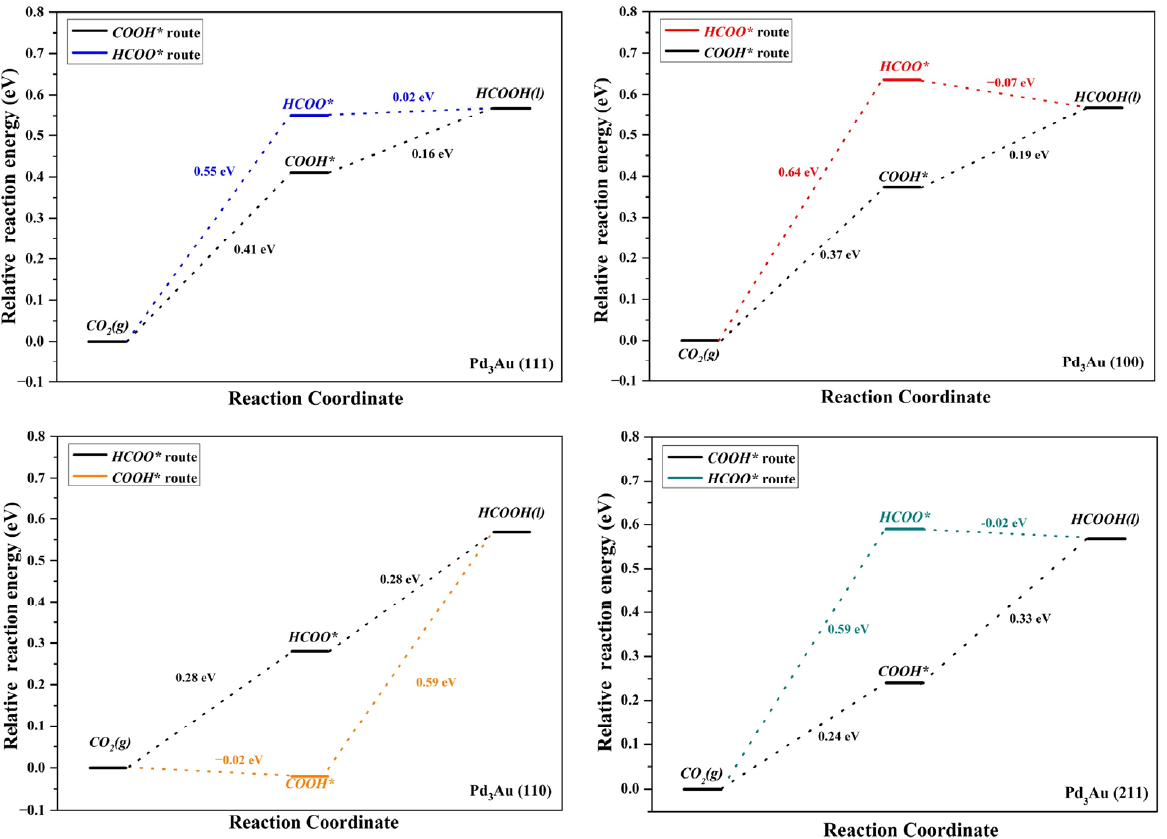
Figure 4. Free energy profiles for CO 2 RR to HCOOH on different Pd 3 Au surfaces (at 0 V vs. RHE).